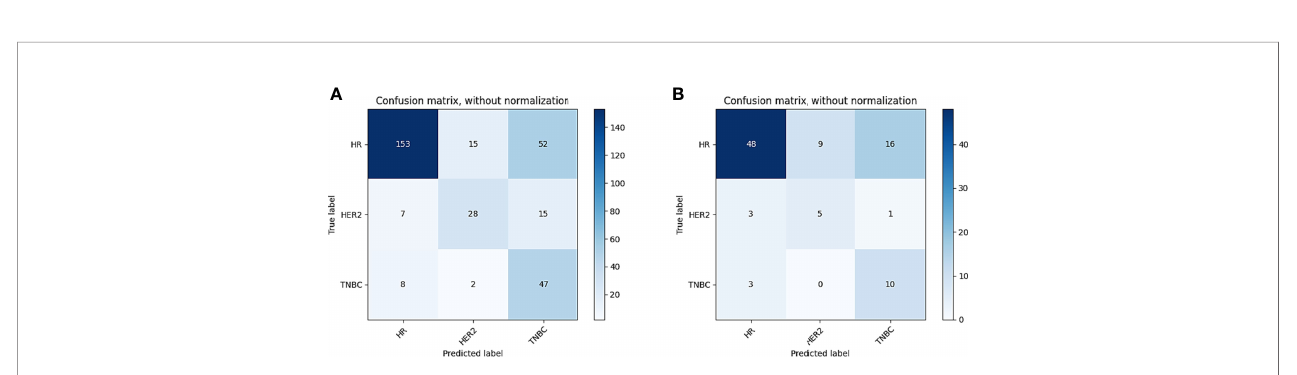
FIGURE 7 | Confusion matrix of CIPRM in task 4. (A) Confusion matrix of the training cohort; (B) confusion matrix of the test